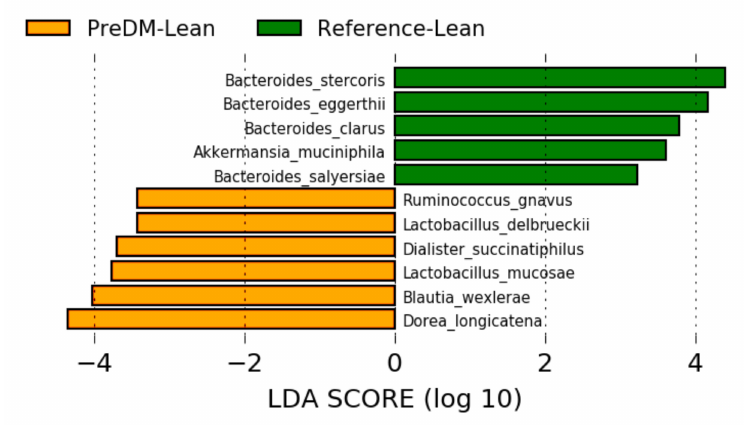
Figure 4. Gut microbiome composition in the PreDM-IR group relative to the Reference group. Linear discriminant analysis (LDA) score (log10) above 2.0 and p <